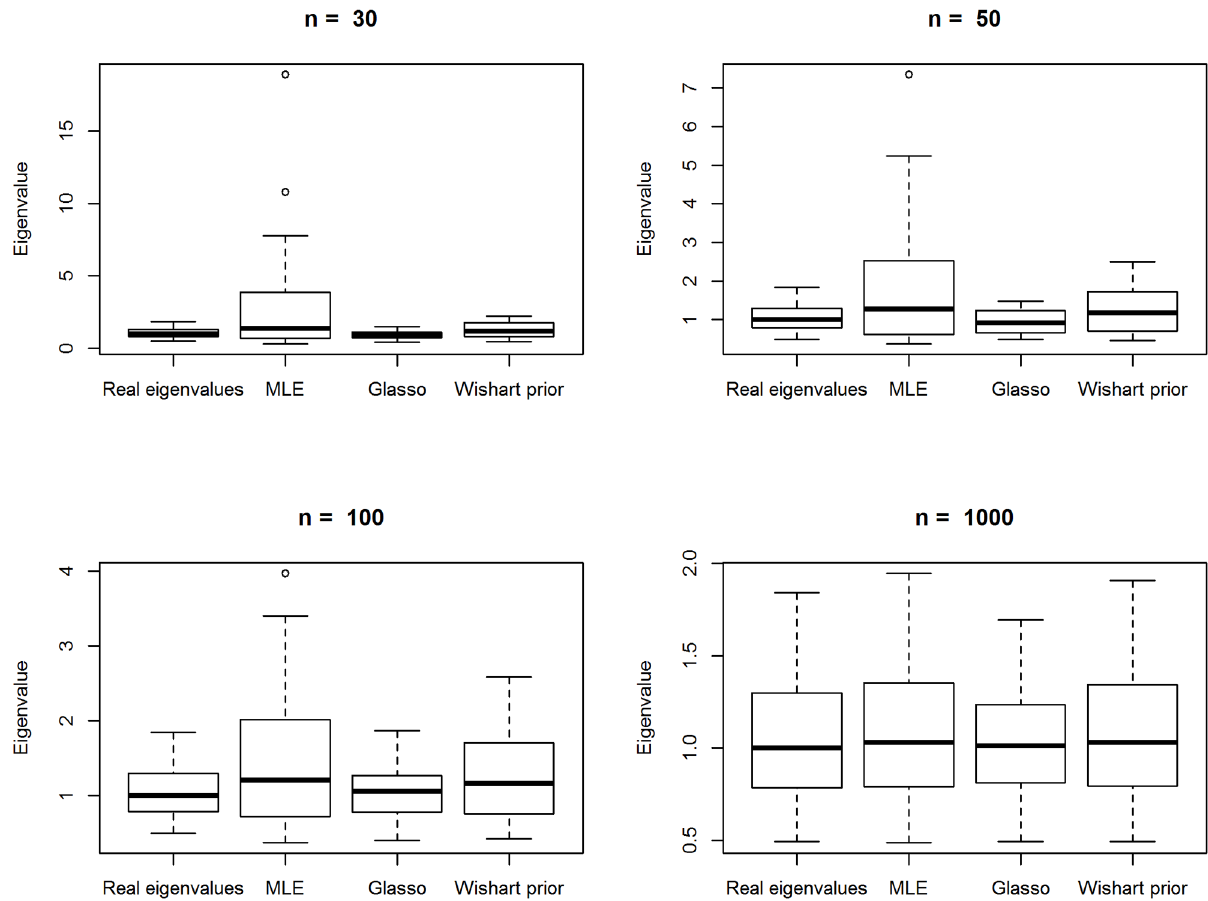
Fig 2. Boxplots of the eigenvalues. From left to right: The eigenvalues of the real precision matrix, the maximum likelihood estimate (MLE), graphical lasso (Glasso, ρ chosen with 5-fold cross-validation) and MAP of Wishart W (2 p , 1/2 pI ) prior when the true precision matrix is sparse (as described in section 3) with sample sizes of 30, 50, 100 and